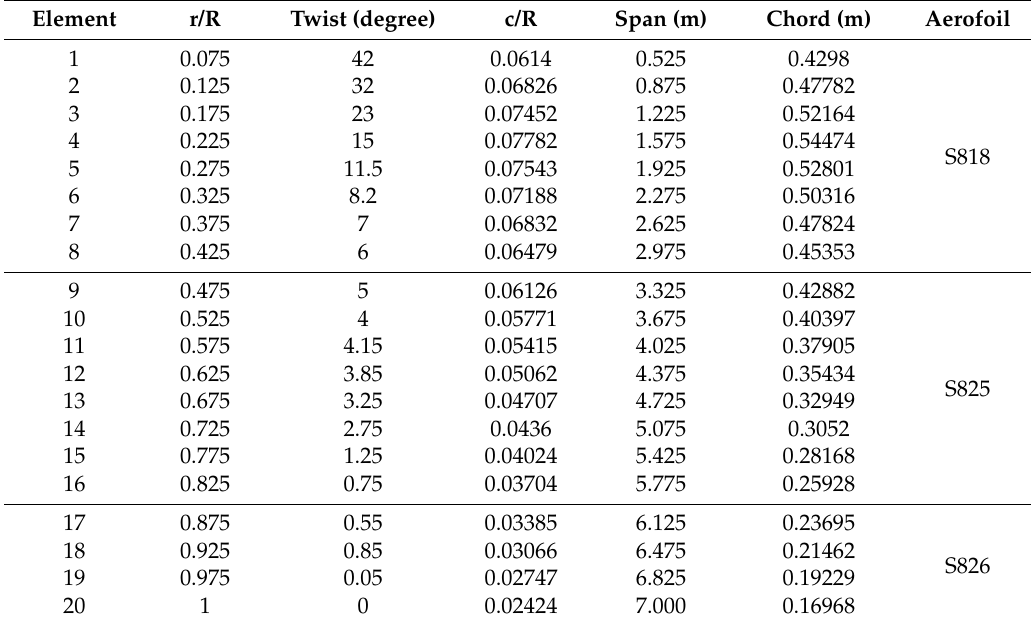
Table 1. Geometries of blade